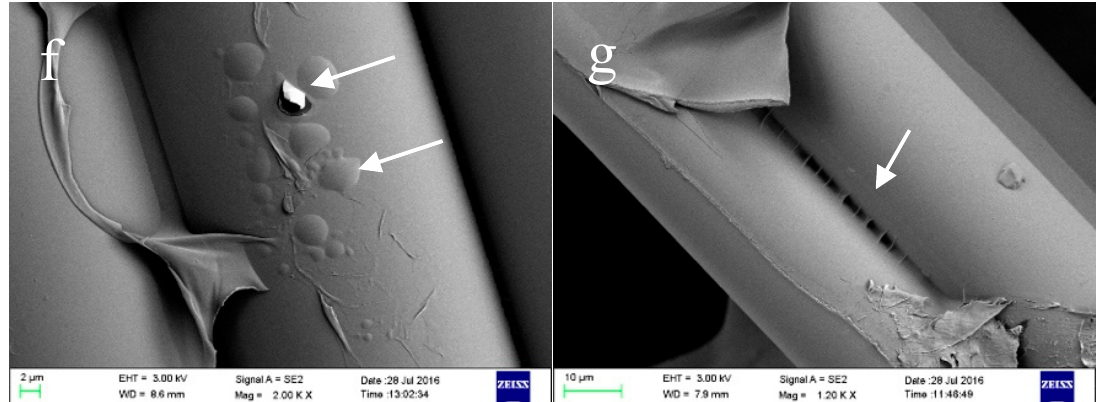
Figure 3. SEM images of coated/uncoated phosphate glass fibres (PGFs). Subfigures ( a – e ) show PCP-0, -3R, -3, -6, and -9, respectively; the scale-length of a = 10 µ m, the magnification (Mag) of a = 500 × , and ( a – e ) share the same factors. ( f ) shows blistering of the PCP-3 fibre surface heated by the electron beam; the scale-length of f = 2 µ m and the Mag of f = 2000 × . ( g ) shows two combined PCP-3 filaments; the scale-length of g = 10 µ m and the Mag of g = 1200 × . The cracked base shows the conductive tape.